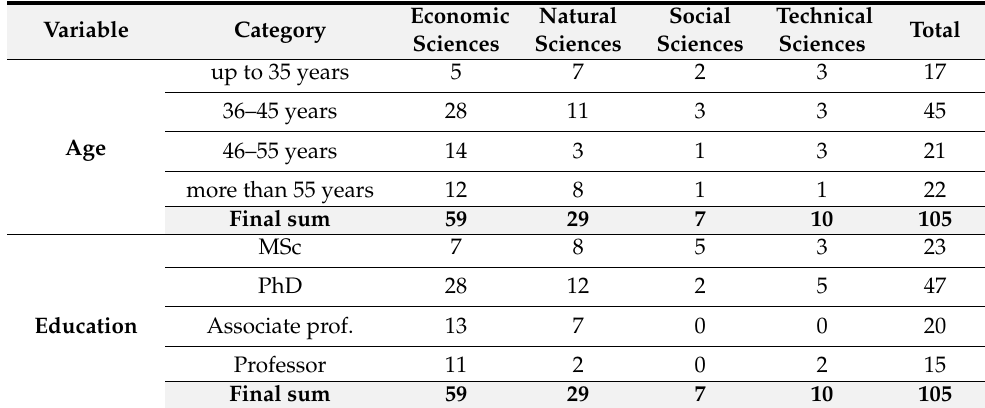
Figure 1. Experts’ opinions on the idea of sustainable development (SD). Source: author’s own compilation based on conducted research. Table 1. The profile of